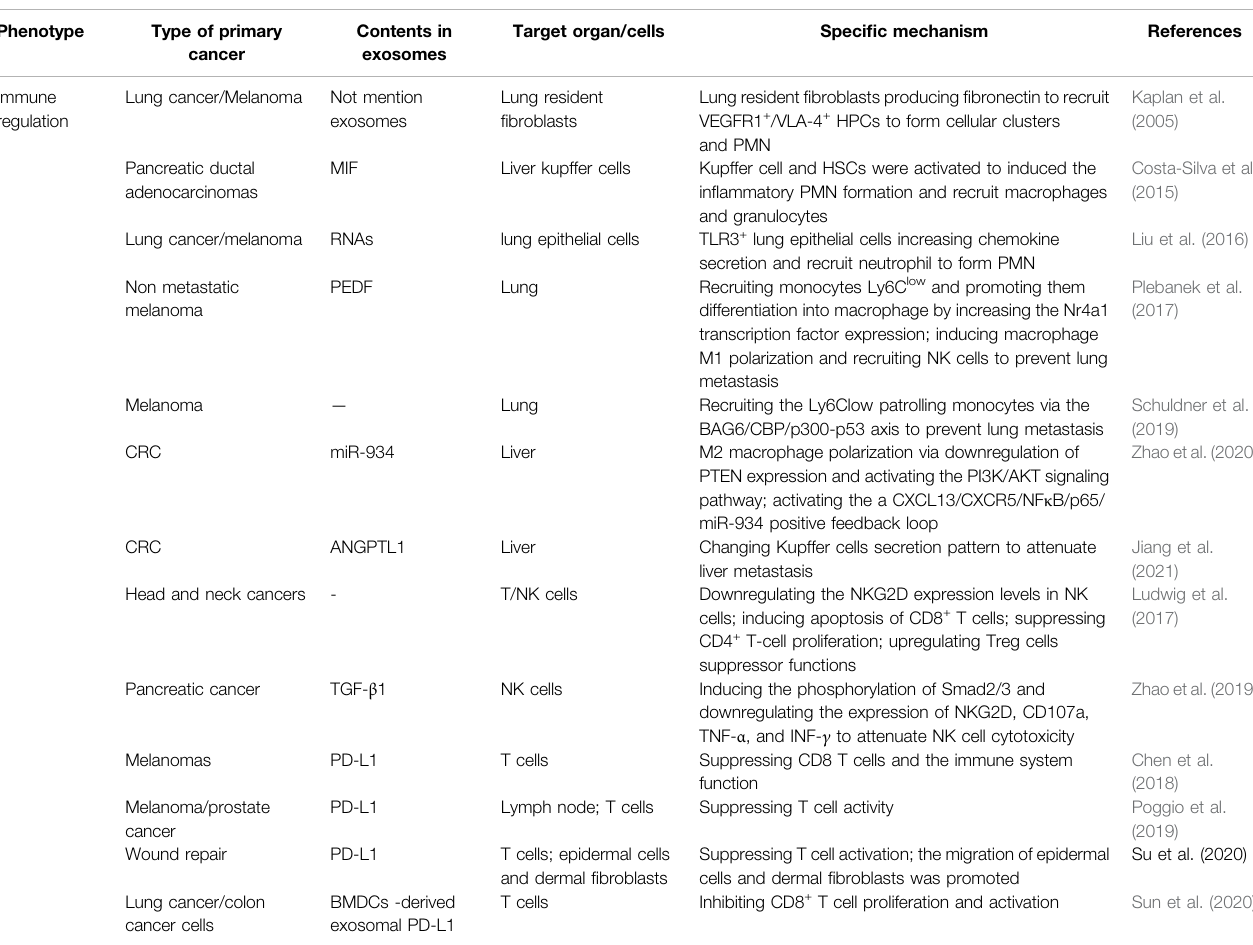
TABLE 3 | The role of exosomes in immune regulation.